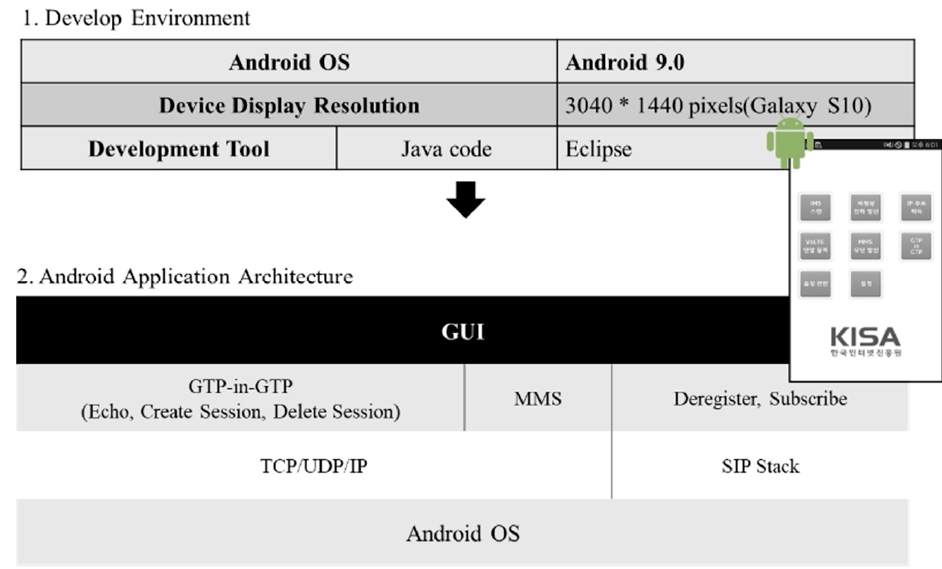
Figure 8. Android application architecture for 5G security threat assessment.